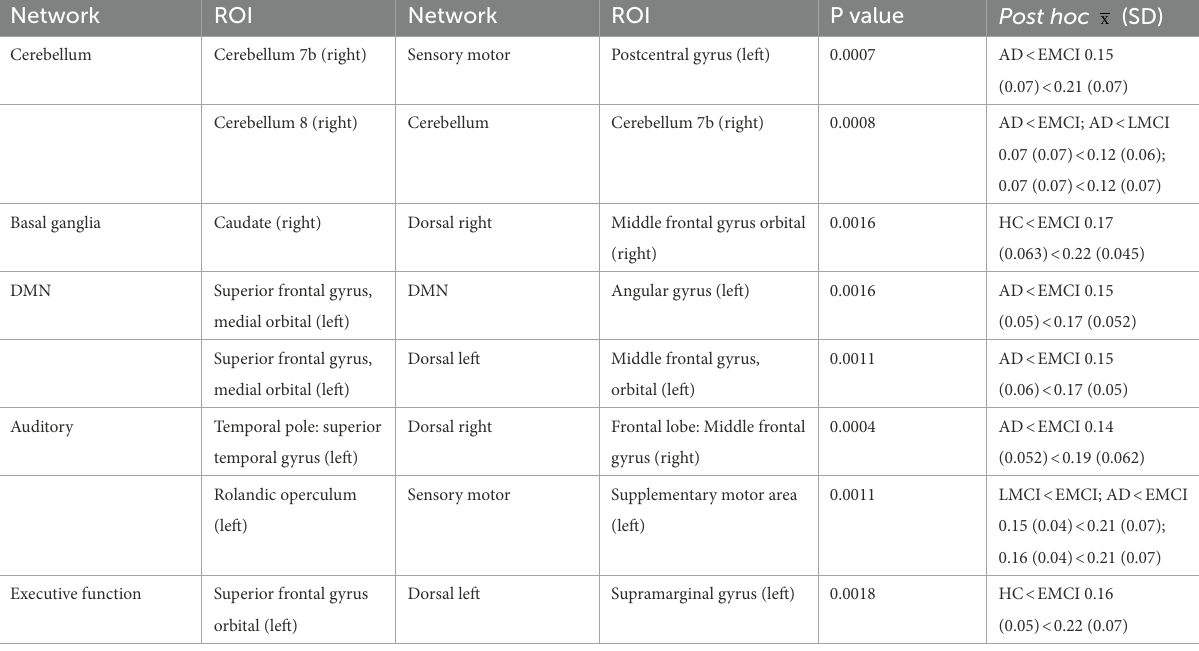
TABLE 4 Between group differences in mean ROI to ROI dispersion across windows using a one-way ANOVA.